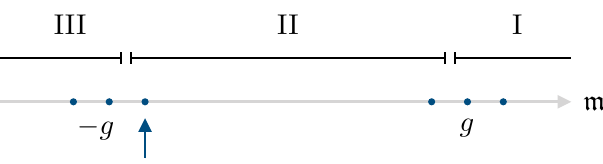
Figure 5 . We separate our computation of the supersymmetric vacua for supersymmetric QED into three di(cid:11)erent regions depending on the (cid:13)ux m in the main